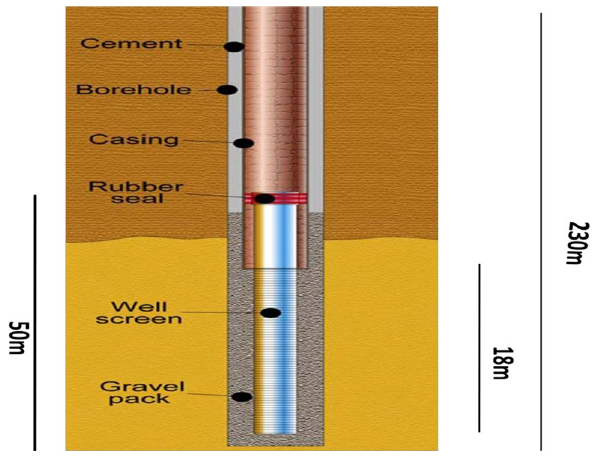
Fig. 13 Borehole design for the surveyed area of Lekki axis Fig. 14 Borehole design for the surveyed area of Ikoyi–Victoria Island